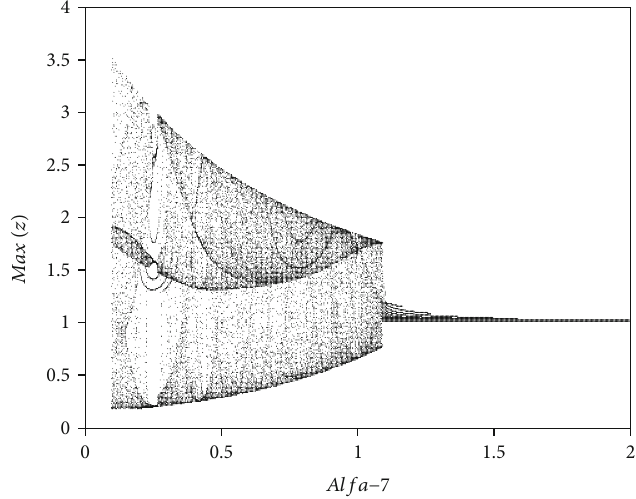
0 : 1 < α < 2 using the parameter values in (90). 7 in the range 7